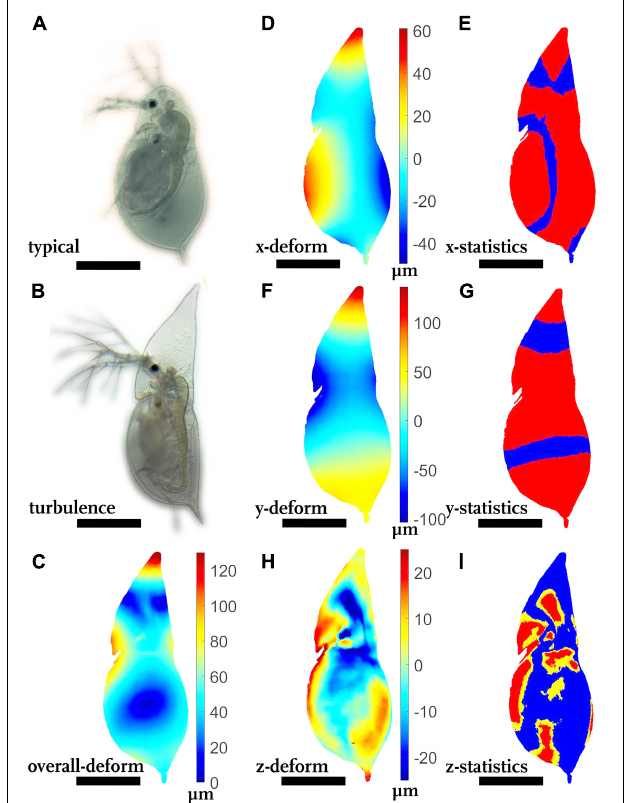
FIGURE 3 | Morphological alterations of turbulence-exposed Daphnia cucullata . (A) D. cucullata , reared in the absence of turbulence. (B) D. cucullata , reared in the presence of turbulence. (C) Overall deformation plot showing the comparison of the unexposed and turbulence-exposed D. cucullata model. Plotted are the vector lengths ( µ m) between the respective vertices on the unexposed and the turbulence-exposed D. cucullata model (blue 0 µ m displacement, dark red 120 µ m displacement). (D,F,H) Shades of blue colors represent alterations in negative direction, while shades of red display shifts in the positive direction. Shades of yellow to white indicate little or no shifts along the respective axis. (E,G,I) p -values lower than 0.05 displayed in yellow, regions supported by q -values lower than 0.01 are colored red. (D) Vertex displacements ( µ m) in x-(dorso-ventral) direction. (E) Wilcoxon test p -values and FDR-analysis q -values for each vertex position of the x-direction. (F) Vertex displacements in y-(longitudinal) direction ( µ m). (G) Wilcoxon test p -values and FDR-analysis q -values for each vertex position of the y-direction. (H) Vertex displacements in z-(lateral) direction ( µ m), (I) Wilcoxon test p -values and FDR-analysis q -values for each vertex position of the z-direction. n undefended = 10, n defended = 10. All scale bars: 600 µ